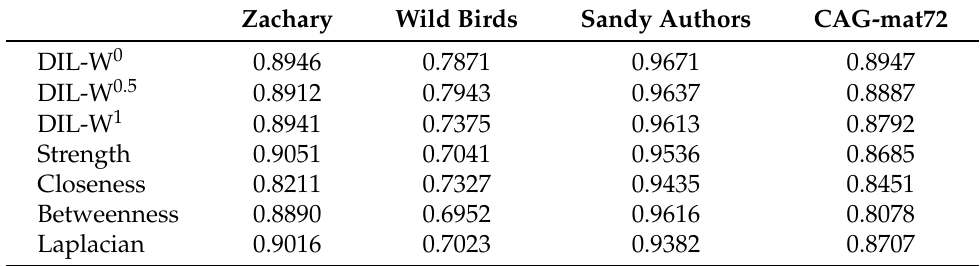
Table 2. Survival rate in each network according to the protection ranking with a protection budget of 10% of the network